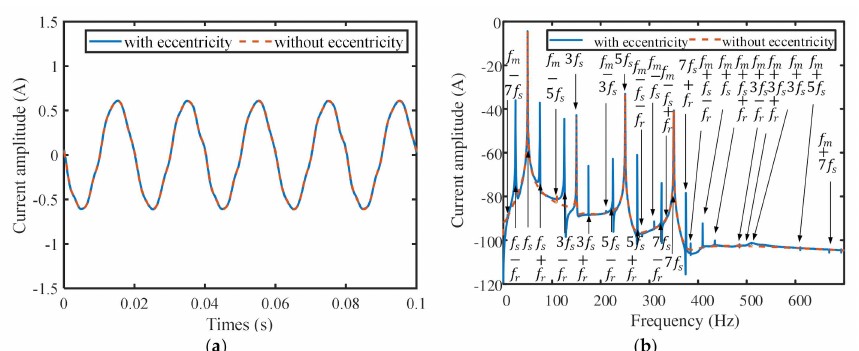
Figure 11. Stator current.